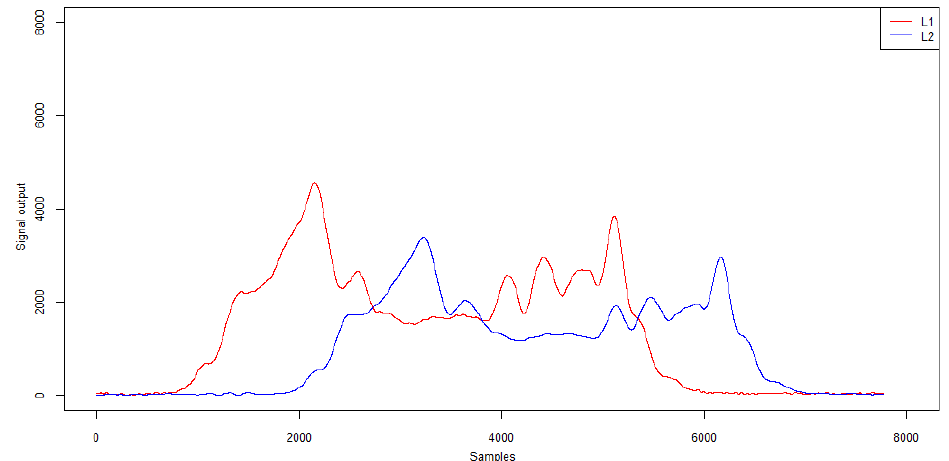
Figure 26. Example of induction loop signals for trajectory changes for a five-axle vehicle. Table 16. Induction loop signal characteristics—amplitude and mean signal value (ADU).